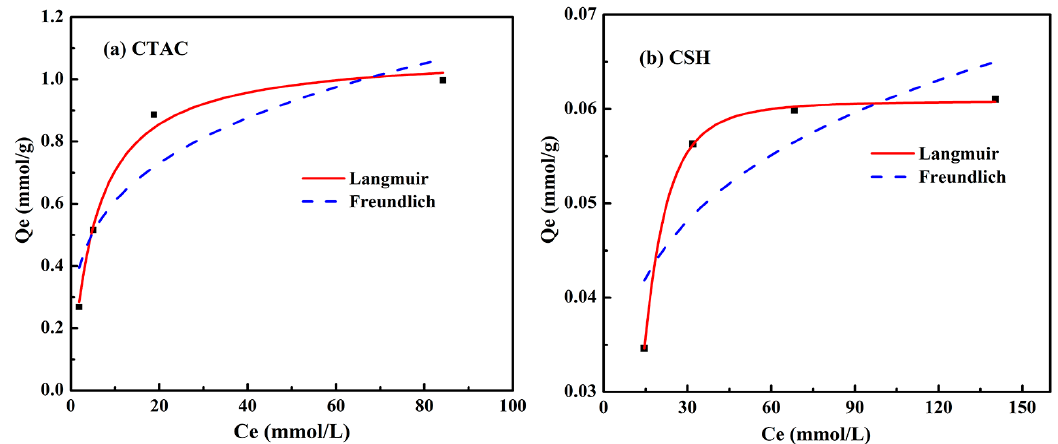
Figure 5. Adsorption isotherms of CTAC ( a ) and CSH ( b ) at 40 °C for Mt. Table 2. Langmuir and Freundlich isotherm parameters for adsorption of CTAC and CSH onto Mt. Modifiers